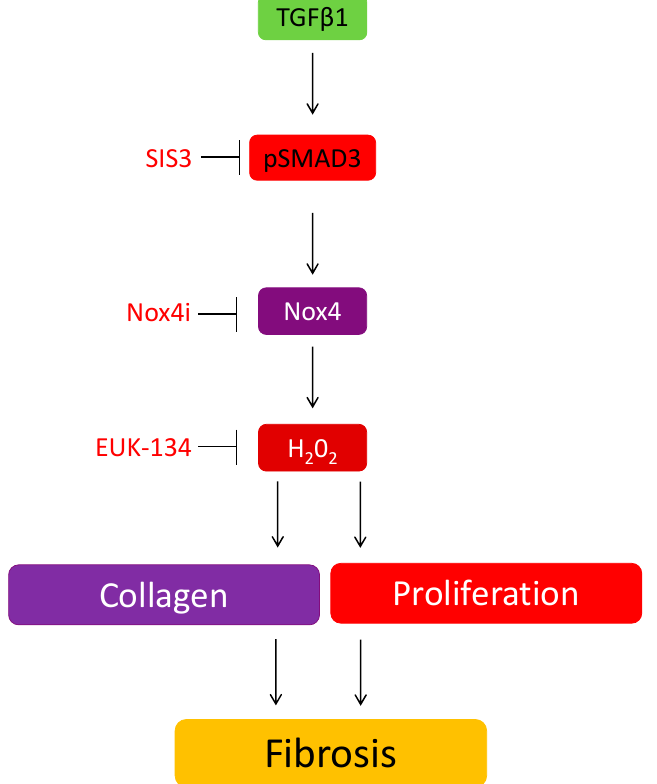
Figure 6. The involvement of Nox4 in the induction of TGF β on collagen and cell proliferation in HTF.